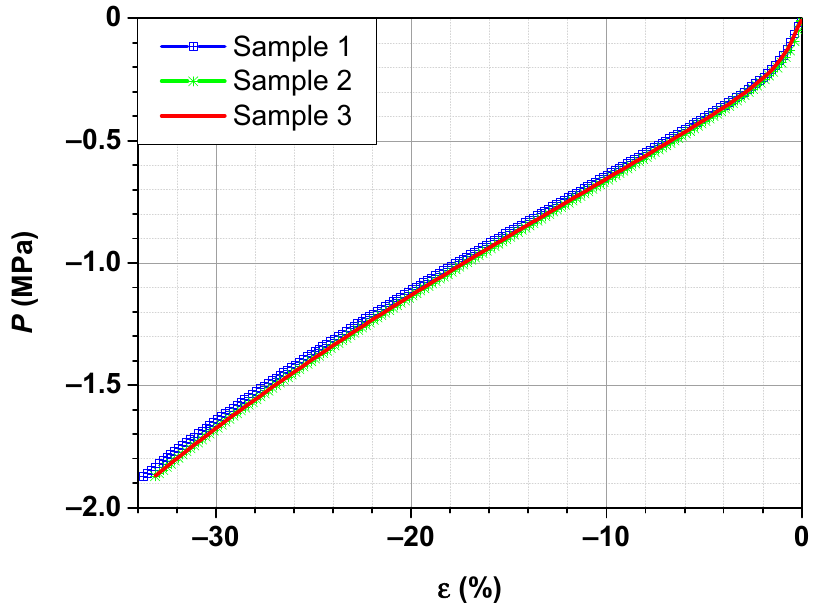
Figure 6. Stress–strain curves measured in compression for SBR filled with 70 phr carbon black N 234 at room temperature and a crosshead speed of 10 mm/min.